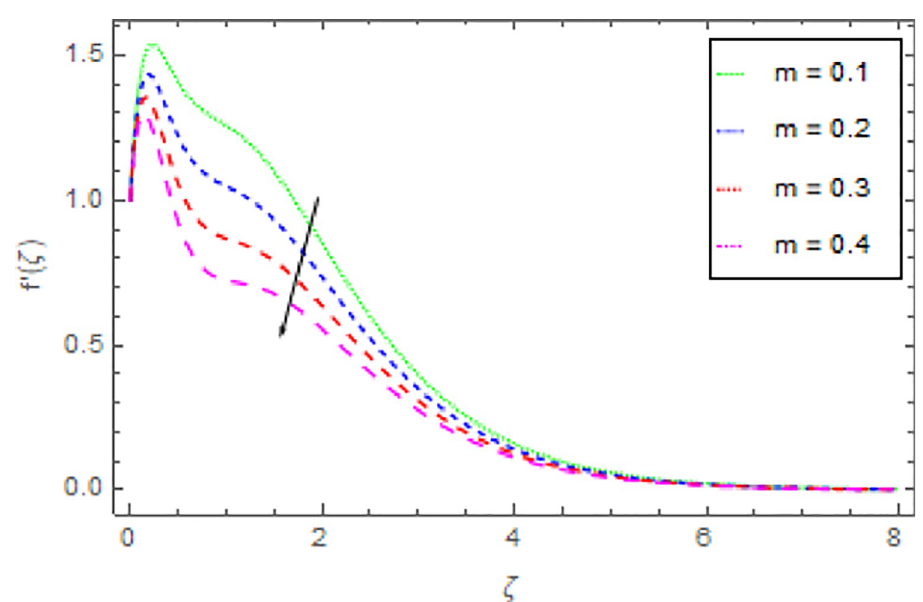
Fig 4. Deviation in nanofluid velocity ( x − direction) against m when Pr = 1000, n = 1.00, M = 2.50, δ = 0.40, β = 1.00, Nr = 0.20 and ϕ = 0.01 to ϕ = 0.04.